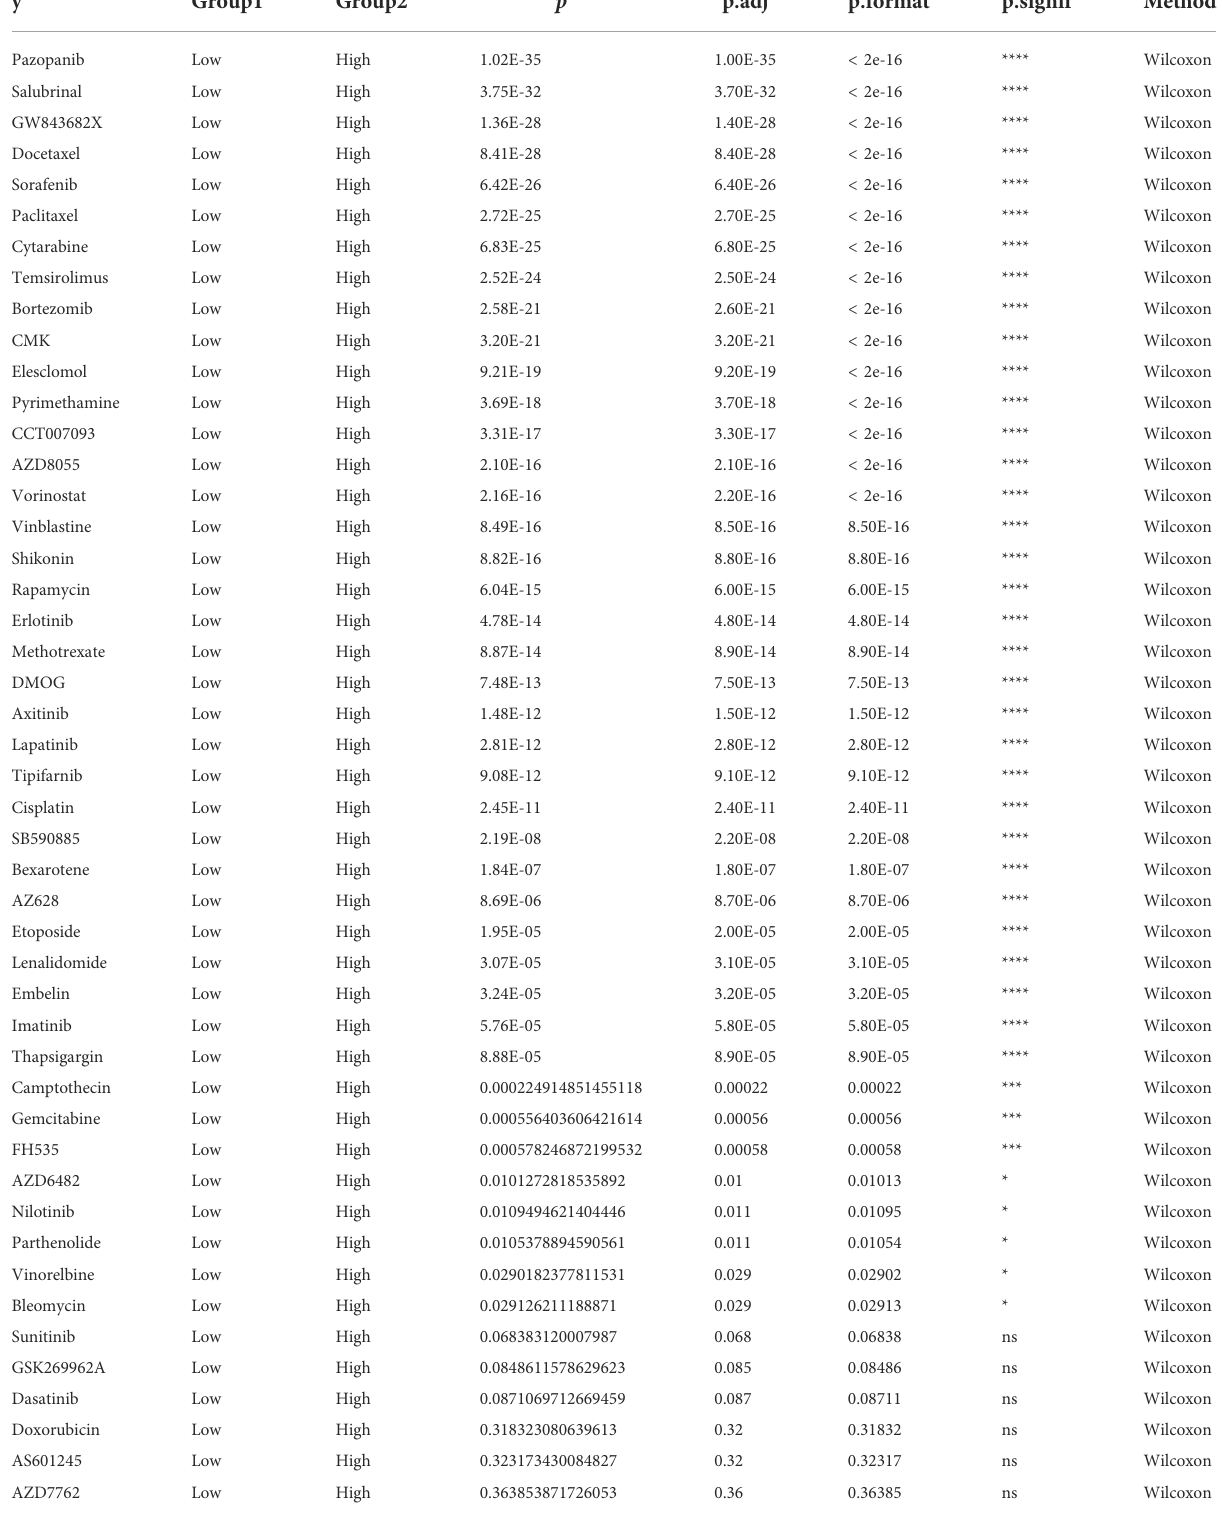
TABLE 1 53 LUAD-associated drugs.